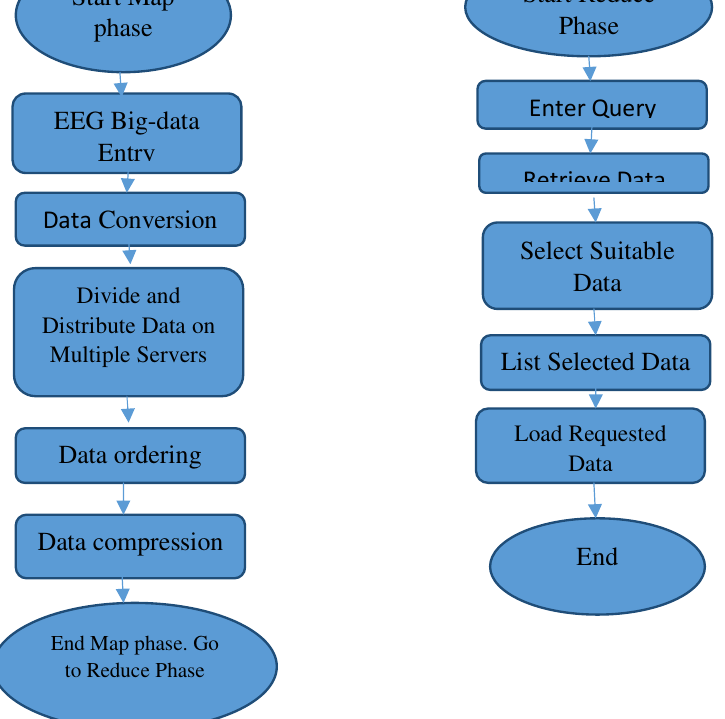
Fig. 1. Proposed Approach Block